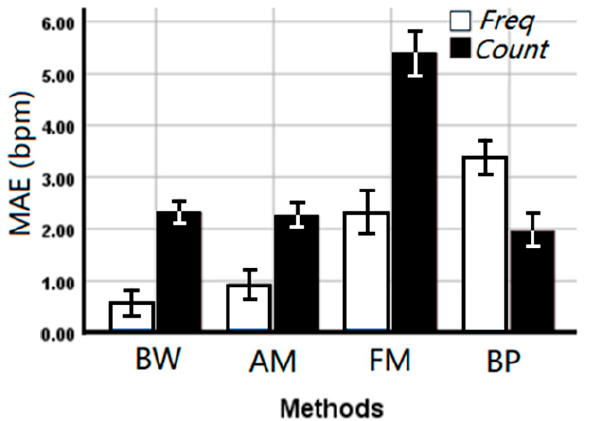
Figure 6. The mean absolute error (MAE ± SE bpm) of the EDR rates between EDR algorithms and estimation methods. Freq: Median frequency in the frequency domain, Count: Automatic counting in the time domain.